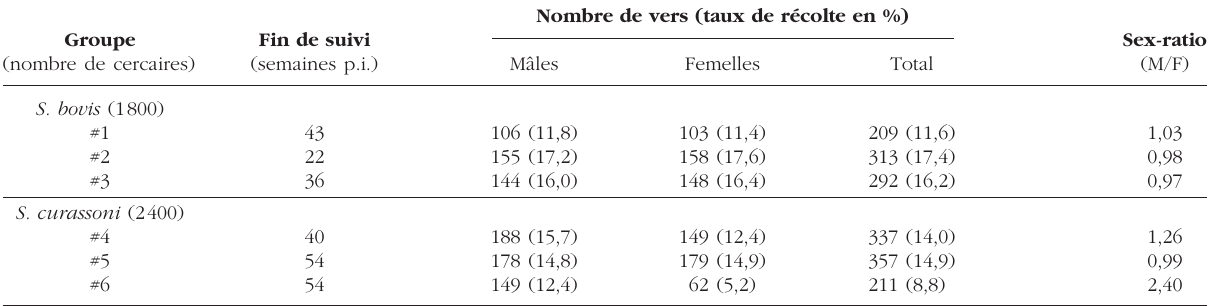
Tableau I. – Charges vermineuses individuelles chez des caprins expérimentalement infestés par deux espèces de schistosomes.